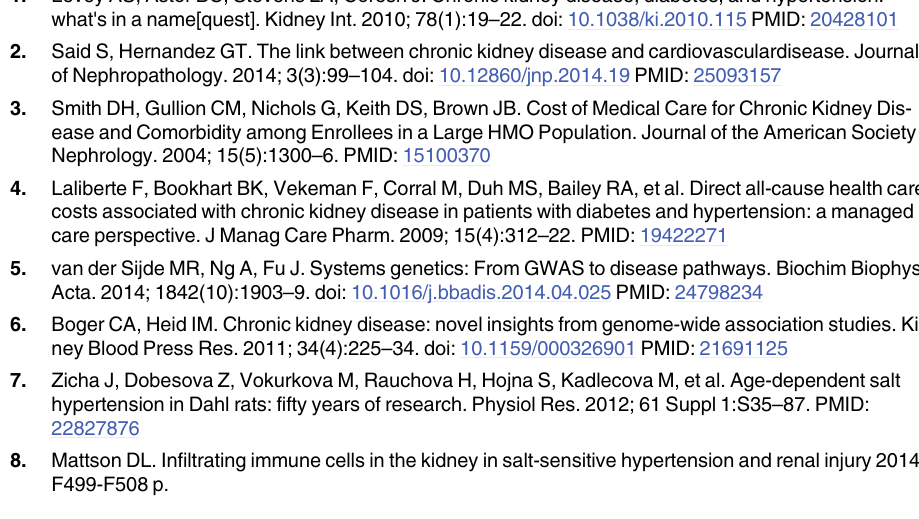
S4 Fig. Analysis of the Rho-ROCK signaling pathway and RhoA activity in stably trans- duced Arhgef11 knockdown NRK cell lines. Cell-culture experiments were performed under several experimental conditions: 1) control (DMEM medium); 2) fasudil (F) (10 μ g/ml) treated for 4hrs; 3) serum free (SF) for 24 hours, or 4) serum free for 24 hrs + fasudil treated for 4 hours (SF+F). ( A ) Real time PCR of Arhgef11 , RhoA , Rock1 , MLC and Cofilin of NRK-shRNA3 compared to LVC (scrambled control). ( B ) RhoA activity between LVC and NRK-shRNA3 under each experimental condition. ( C ) Western analysis of Rho-Rock pathway in LVC and NRK-shRNA3 between control and fasudil treatment. Similar results were observed for LVC and HEK293-shRNA3 ( Fig 4 ). n = 6 independent samples per group/treatment, (cid:1) p < 0.05 ver- (TIF) S5 Fig. Densitometry measurement of Arhgef11-Rho-Rock proteins between LVC and HEK293-shRNA3 between control, fasudil treatment, and serum free conditions. ( A ) Den- sitometry measurement of Rho-Rock pathway in LVC and HEK293-shRNA3 between control and fasudil treatment; and ( D ) Densitometry measurement of Rho-Rock pathway in LVC and HEK293-shRNA3 between control and serum free conditions. n = 6 independent samples per group/treatment, (cid:1) p < 0.05 versus LVC. Error bars are ±SD. (TIF) S6 Fig. RhoA Activity in primary proximal tubule cell (PTC) treated with TGFß-1. Primary PTC cells (day 5, > 60% confluent) were grown from S and Arhgef11-congenic kidney (at 4 weeks of age) and treated with TGFß-1 (10 ng/ml) for 48 hrs. ( A ) Western analysis and densi- tometry of Arhgef11 and RhoA signaling pathway. ( B ) RhoA activity. n = 6 independent sam- ples, (cid:1) p < 0.05 versus S; † p < 0.05 versus S and S+ TGFß-1. Error bars are